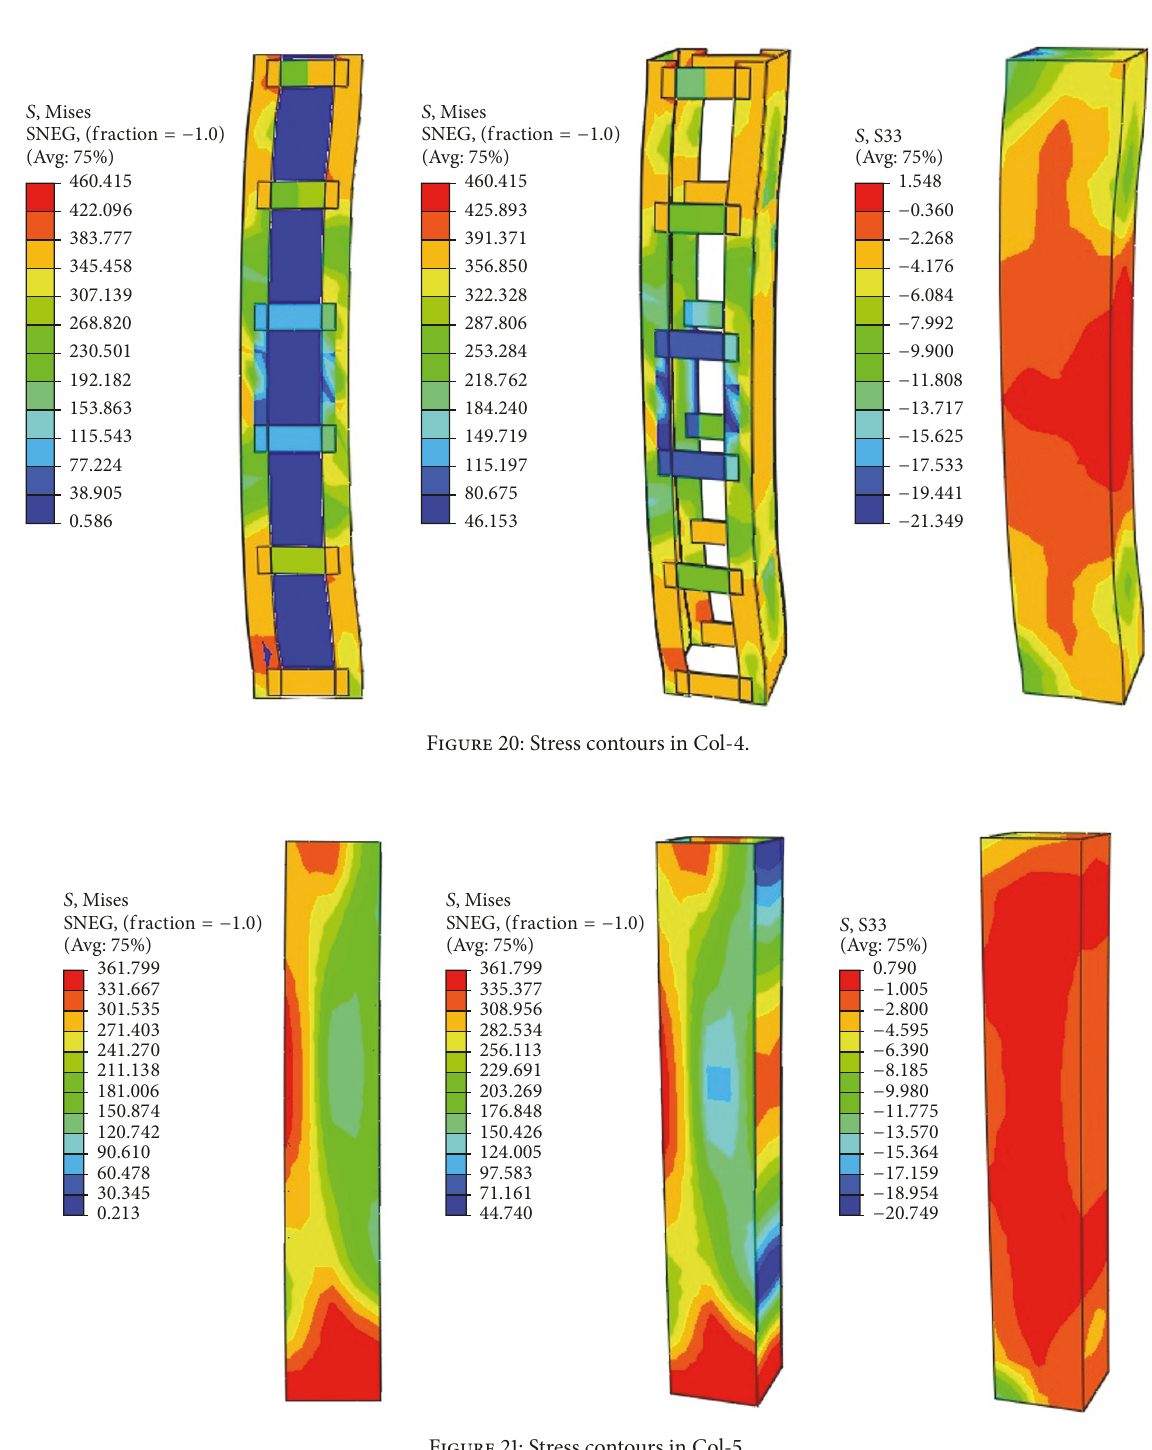
Figure 21: Stress contours in